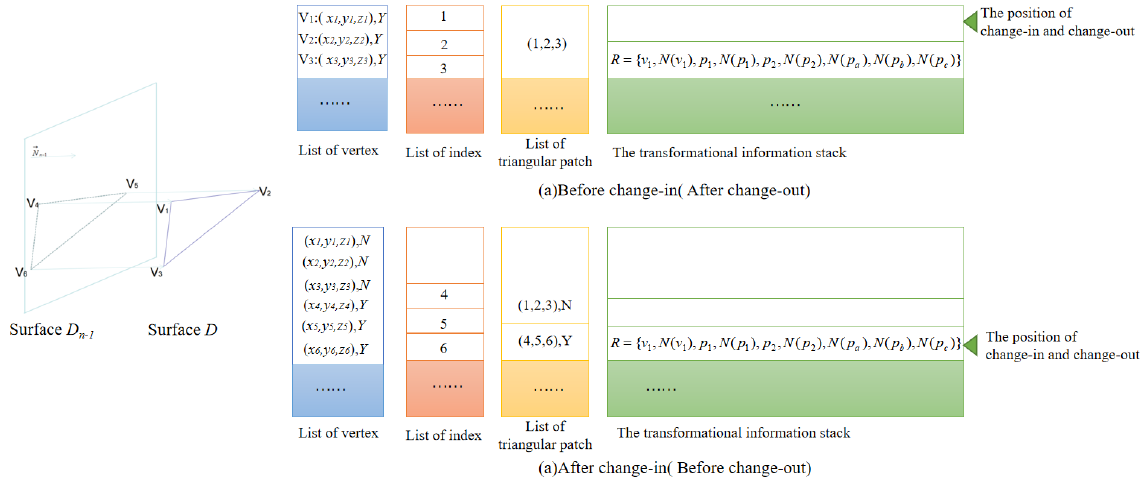
Figure 6. Change-in and change-out operation in a transformational information stack.